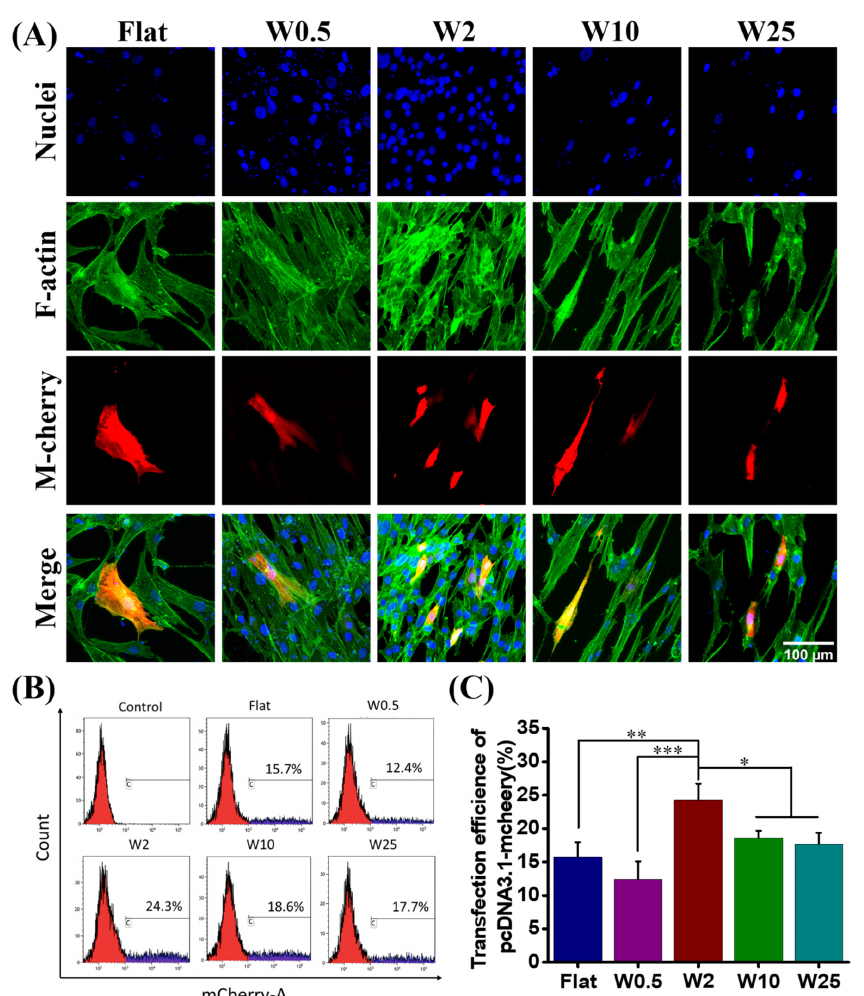
Figure 3. Influence of nano- and micropatterns on the transfection capacity of hBM-MSCs. ( A ) Representative fluorescence microscopy images of transfect hBM-MSCs after 24 h. F-actin and cell nucleus were stained with FITC-labeled phalloidin (green) and by DAPI (blue), respectively. The transfected cells are m-cheery express cells (red). ( B ) Flow cytometry profiles obtained after the treatment with LF2000/pDNA encoding m-cheery proteins. The percentage of transfected cells was evaluated and hBM-MSCs cells without a transfection agent were selected as the control. ( C ) Quantification data of transfected cells grown on different topographies. Three independent experiments were presented. Data are shown as mean ± standard deviation (SD), and * p < 0.05, ** p < 0.01, *** p < 0.001. Scale bar is 100 µm and applies to all images.